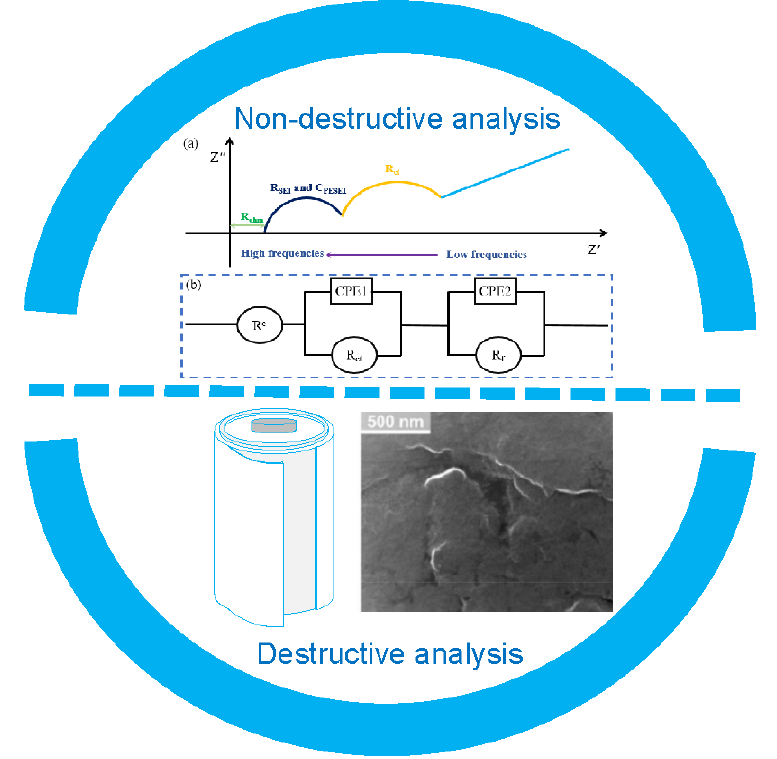
Figure 1. The structure of the review. Combination of destructive and non-destructive techniques is essential for understanding degradation mechanisms and lifetime predication. ( a ) Typical electro- chemical impedance spectroscopy and ( b ) Equivalent circuit model of Lithium-ion